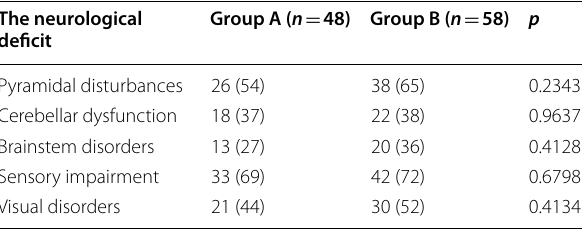
Table 1 The incidence of neurological deficit among the patients of both groups (n, %)